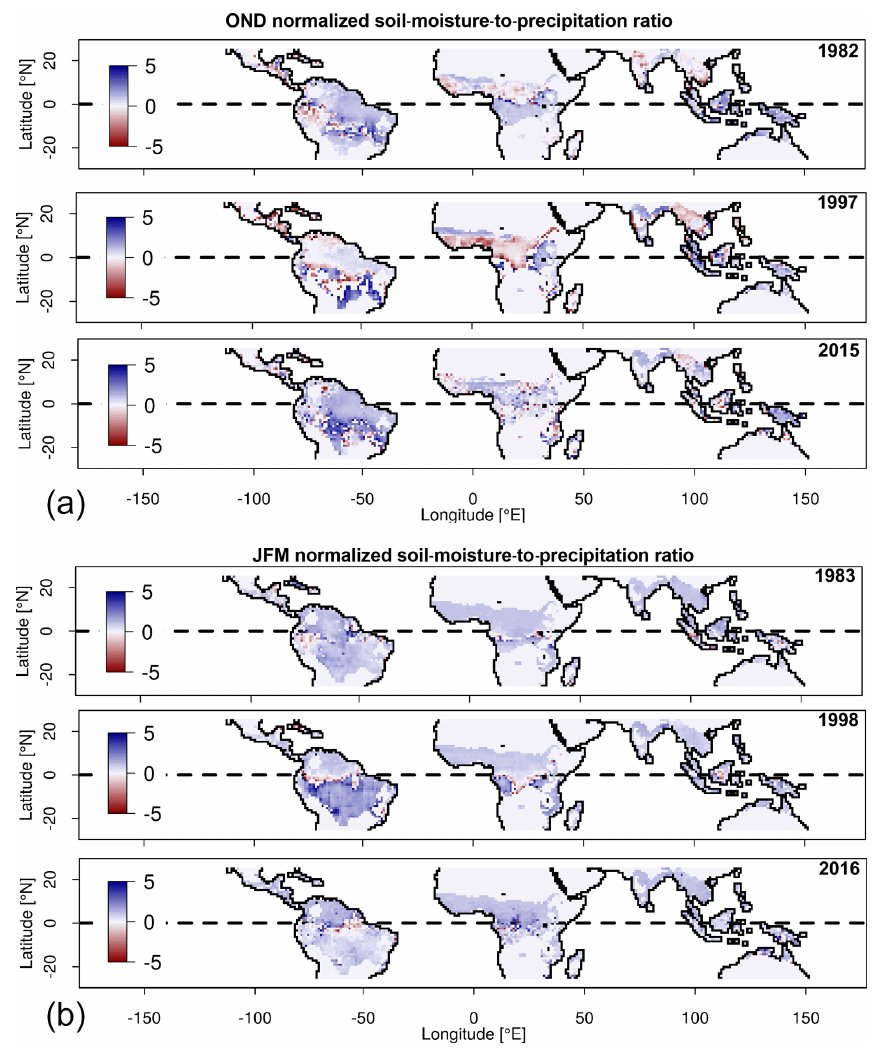
Figure 7. (a) Ratio of bias-corrected GLDAS soil-moisture-to-precipitation change computed using October-to-December (OND) anomalies during El Niño years 1982–1983, 1997–1998 and 2015–2016 relative to previous years. Anomalies relative to the 1979–2016 period. (b) Same as (a) but for January to March in 1983, 1998 and 2016. Table 4. Mean and standard deviation of October-to-December (OND) and January-to-March (JFM) change in the soil-moisture-to- precipitation ratio for the same regions shown in Table 3. Statistics computed using OND and JFM bias-corrected GLDAS soil